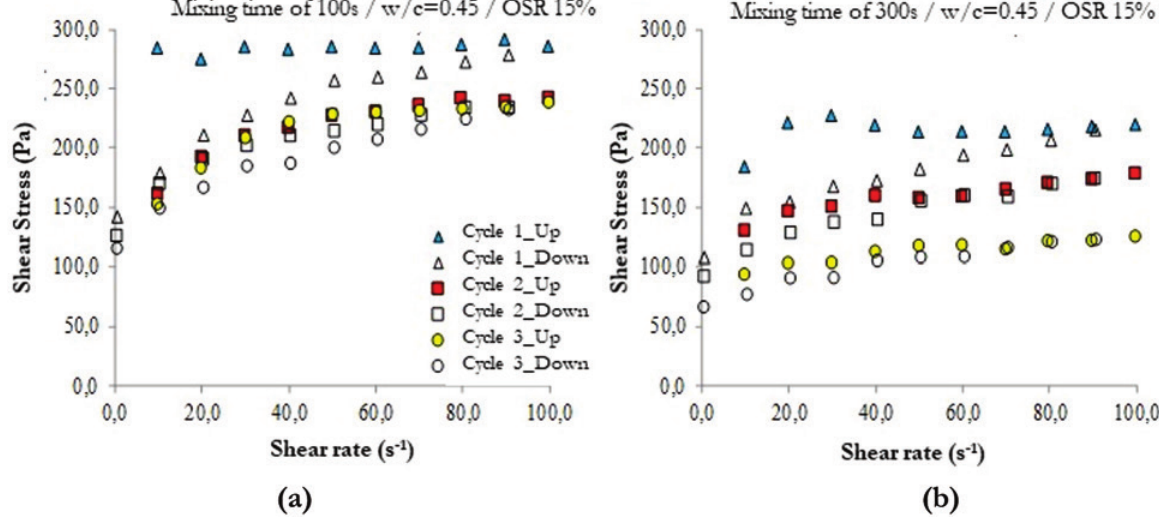
Shear stress vs. shear rate of the mixing times of (a) 100 seconds and (b) 300 seconds